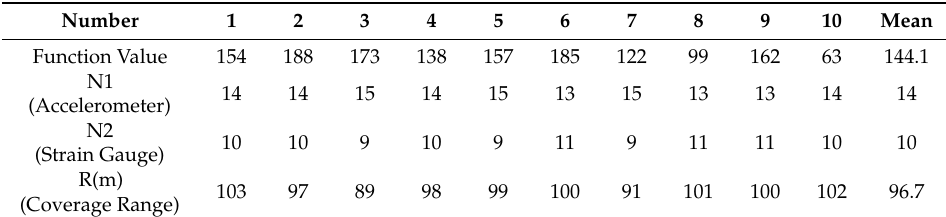
Table 4. Results of the PSO running 10 times.